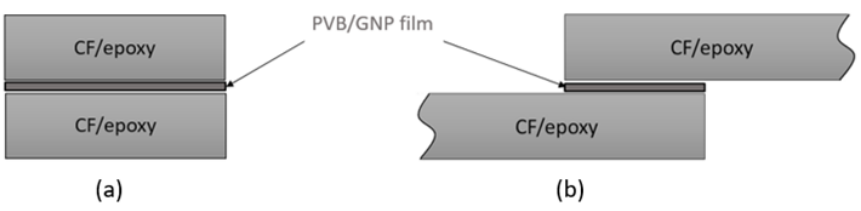
Figure 2. Schematic representation of the CF/Epoxy/PVB joints in ( a ) ILSS and ( b ) LSS configura-